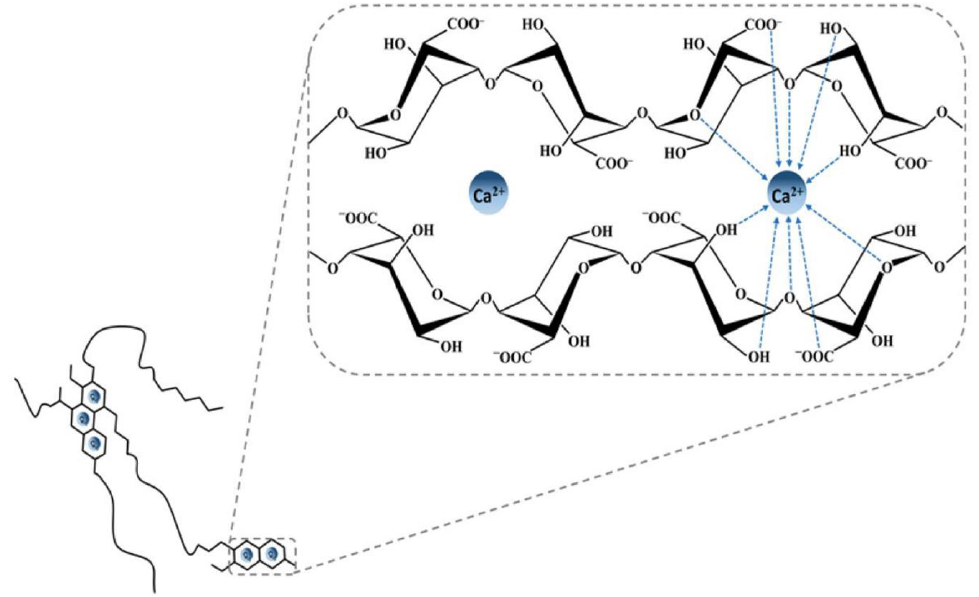
Figure 8. Egg-box model representing the interactions between alginate G -blocks and calcium ions. Reprinted from [113] . Copyright (2019) Martău, Mihai, Vodnar.